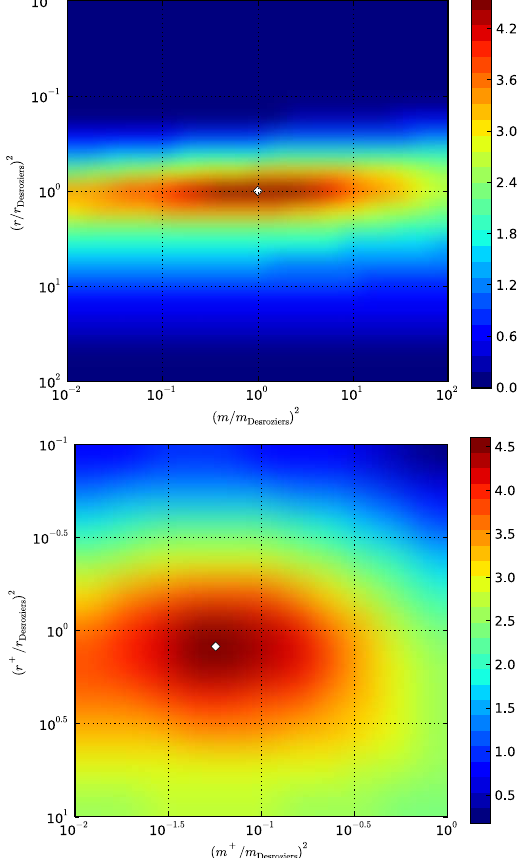
Fig. 3. These density plots display a monotonic transform of the